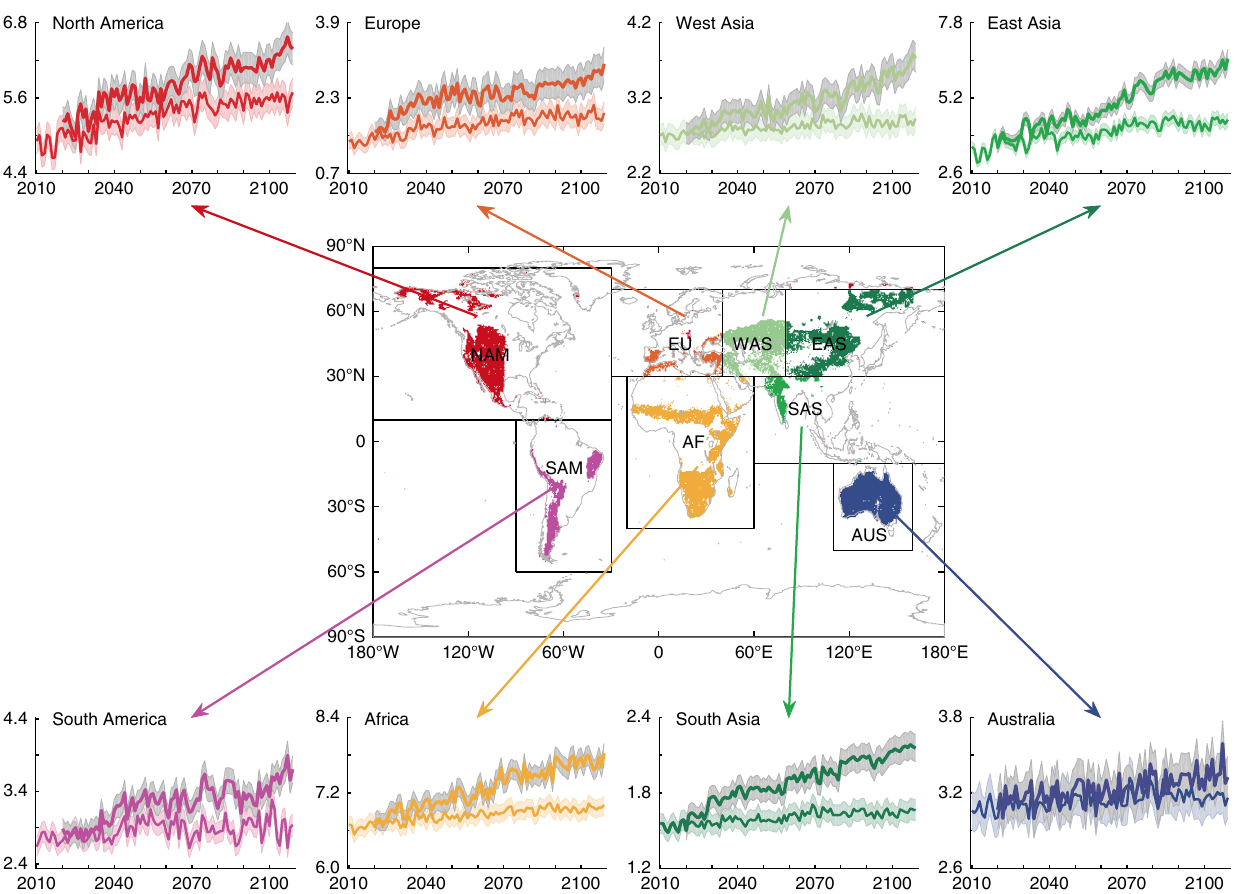
Fig. 5 Temporal variations of GPP in the eight regions (2010 – 2100). The curves with the small and large gross primary production (GPP) in units of Pg C year − 1 are under RCP4.5 and RCP8.5, respectively. The shaded areas denote 95% con fi dence intervals.